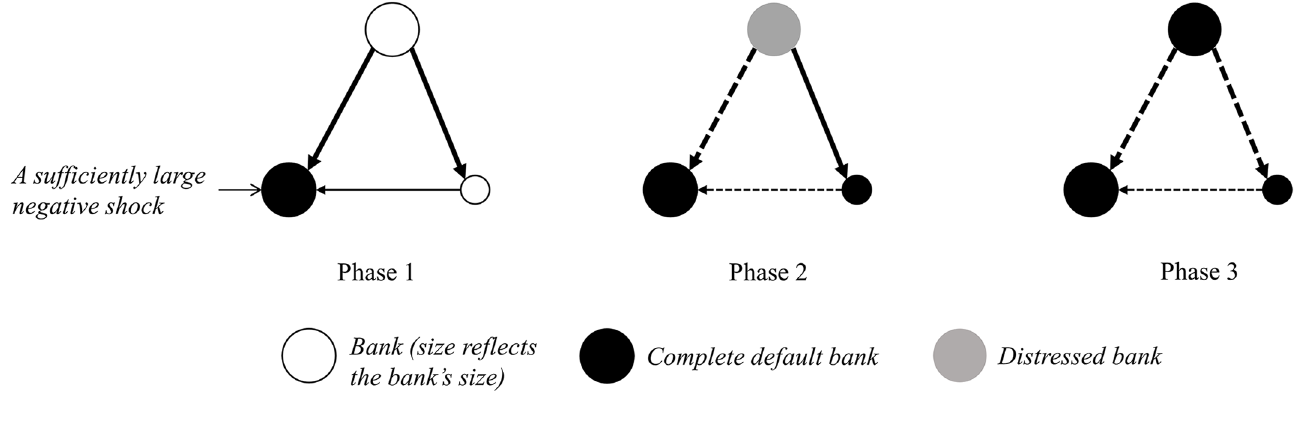
Fig 2. Sketch map of risk